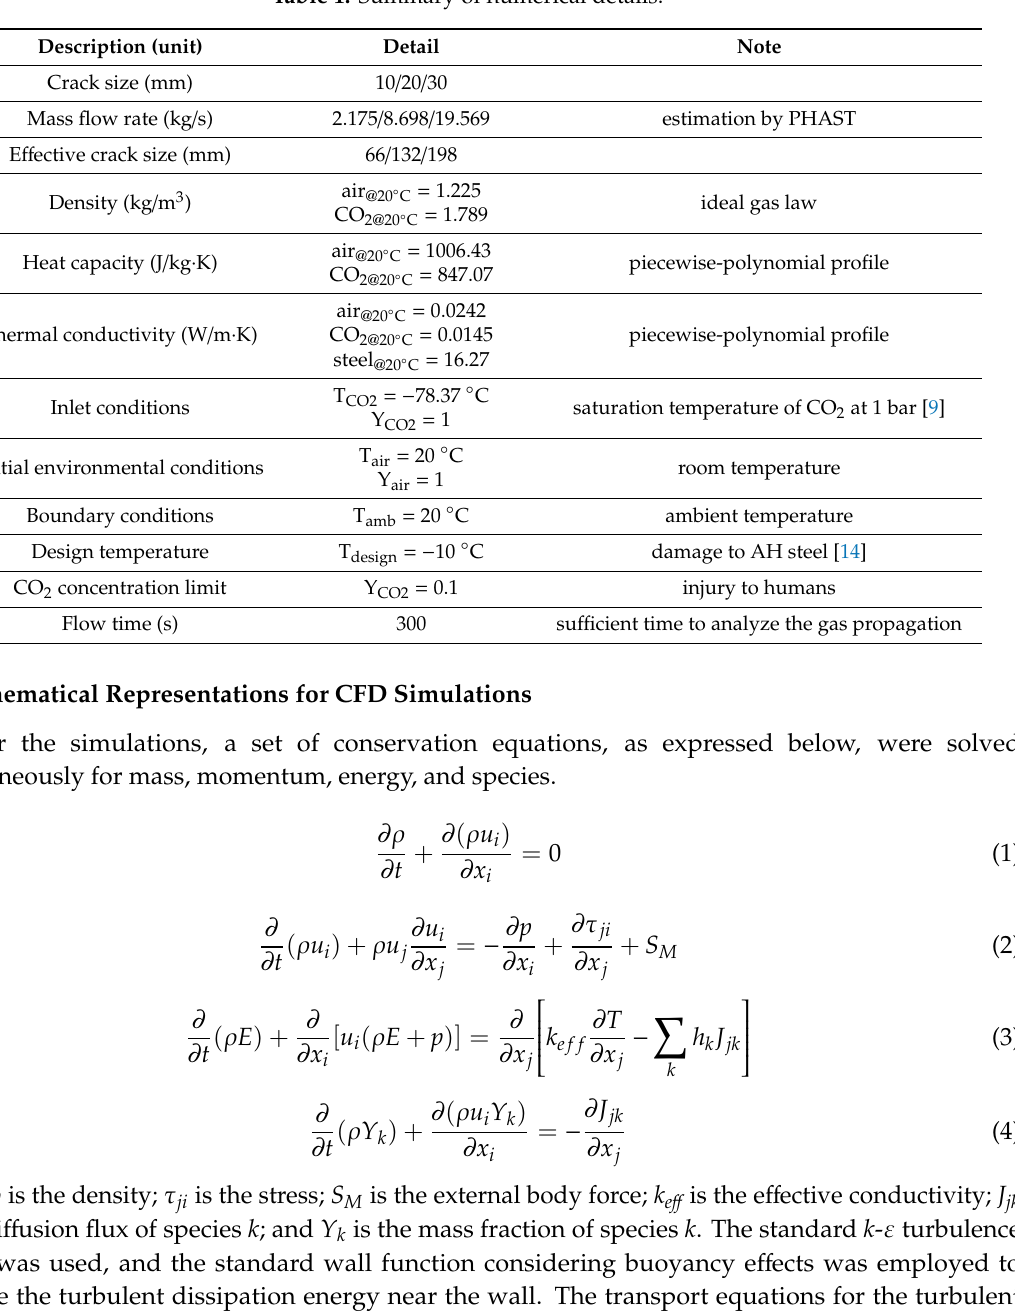
Table 1. Summary of numerical